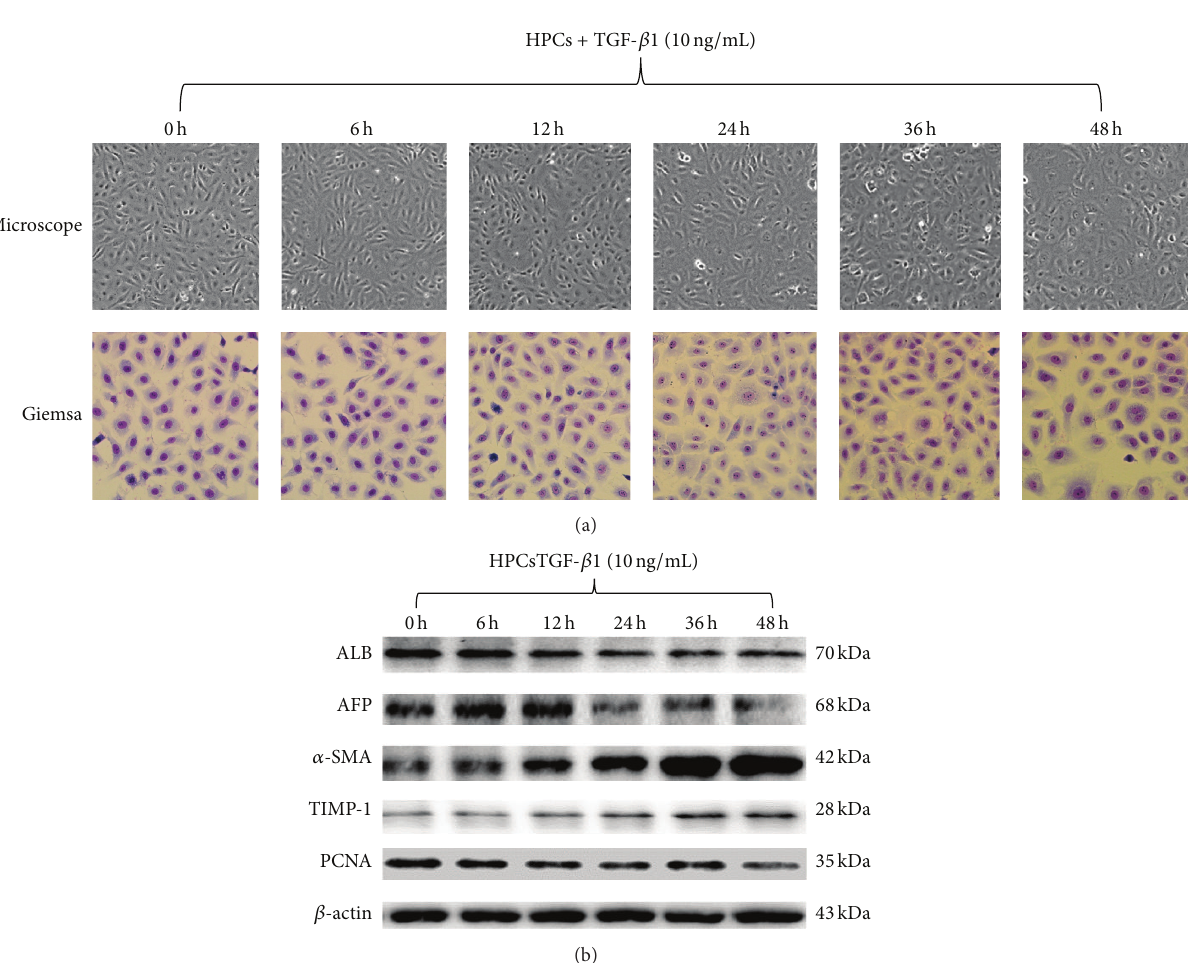
Figure 1: Transforming growth factor-beta 1 (TGF- 𝛽 1) induced a mesenchymal morphology in HPCs. HPCs were cultured in the presence (10ng/mL) or absence of TGF- 𝛽 1 for 48 h. The phenotypic changes (transition toward a myofibroblast-like phenotype) were evaluated by phase-contrast microscopy and Giemsa staining (a). Changes in differentiation markers were evaluated by western blot